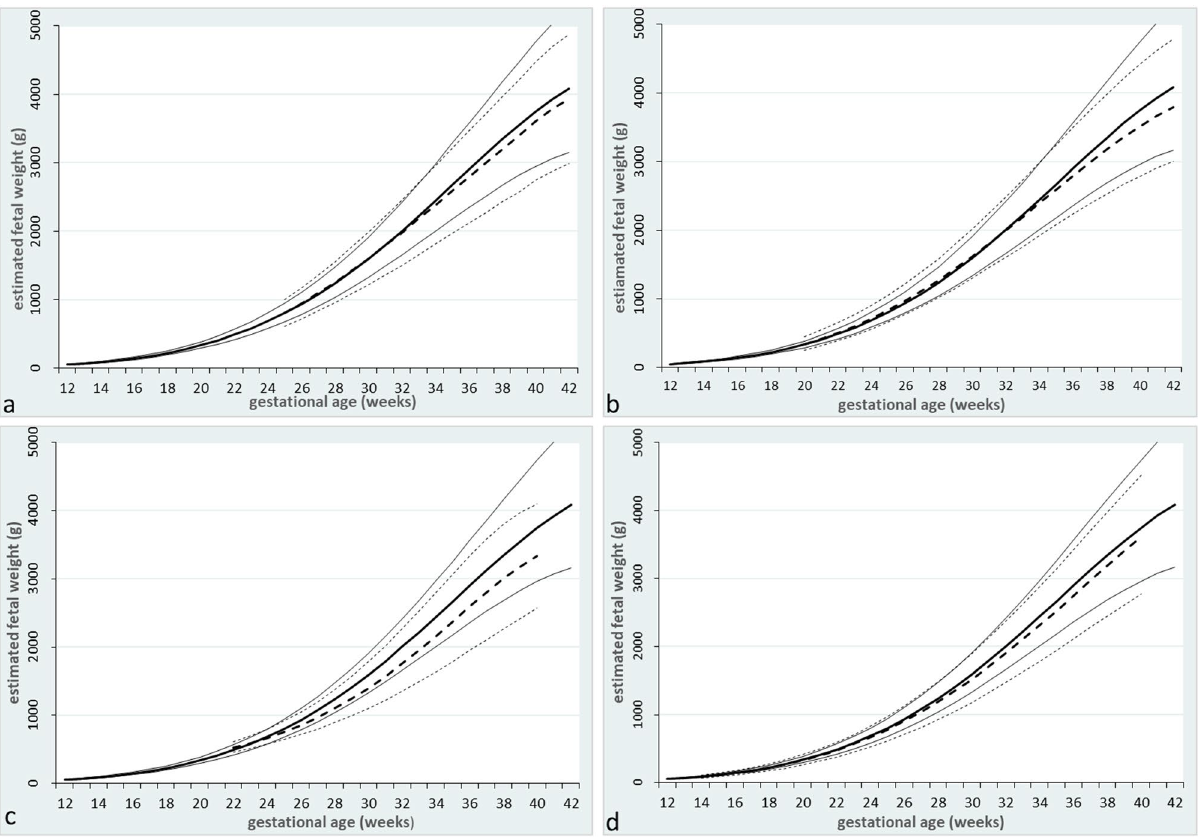
Figure 6. Comparisons of estimated fetal weight for males and females in the present study with other reference ranges; ( a ) new reference ranges (continuous) versus Maršál et al 10 (dashed), + 2 SD, median, − 2 SD; ( b ) new reference ranges (continuous) versus Johnsen et al 36 (dashed), 2.5th percentile, median, 97.5th percentile; ( c ) new reference ranges (continuous) versus INTERGROWTH-21st 21 (dashed), 2.5th percentile, median, 97.5th percentile; ( d ) new reference ranges (continuous) versus WHO 20 (dashed), 2.5th percentile, median, 97.5th